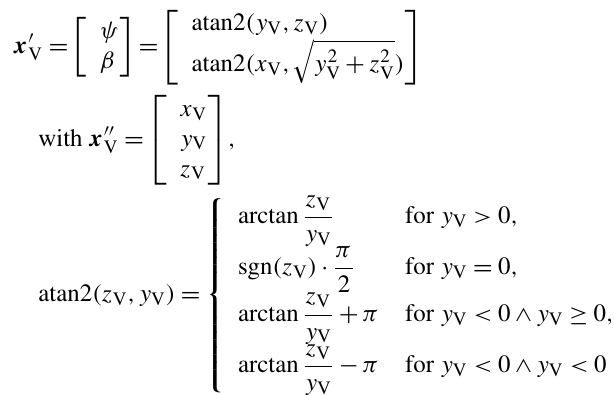
Figure 5. Two corresponding ray directions x by the angles ψ L and ψ R within the epipolar plane. With baseline length b the distance s between left camera and 3-D Point P can be derived, which allows the determination of 3-D point coordinates (cid:48)(cid:48) P = s x L